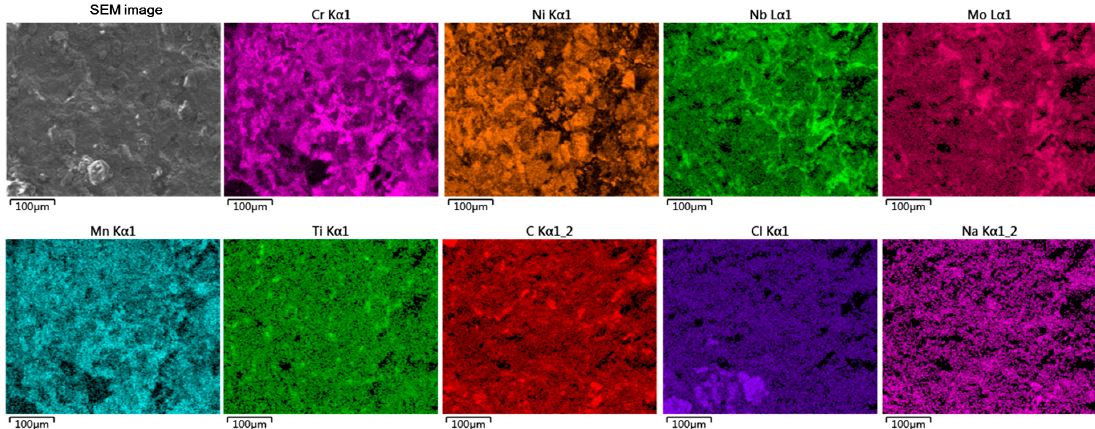
Figure 8. The surface analysis based on SEM: specimens ( a – d ) #2 and ( a’ – d’ ) #4.